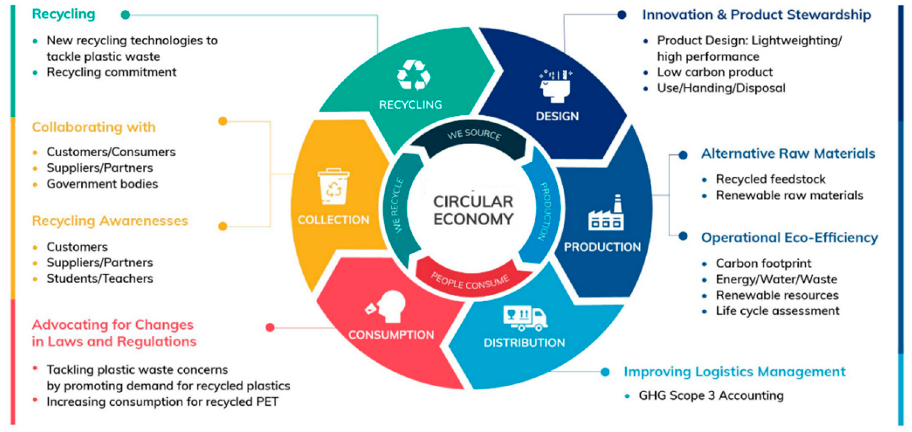
Figure 2. Circular Economy Cycle [19] .